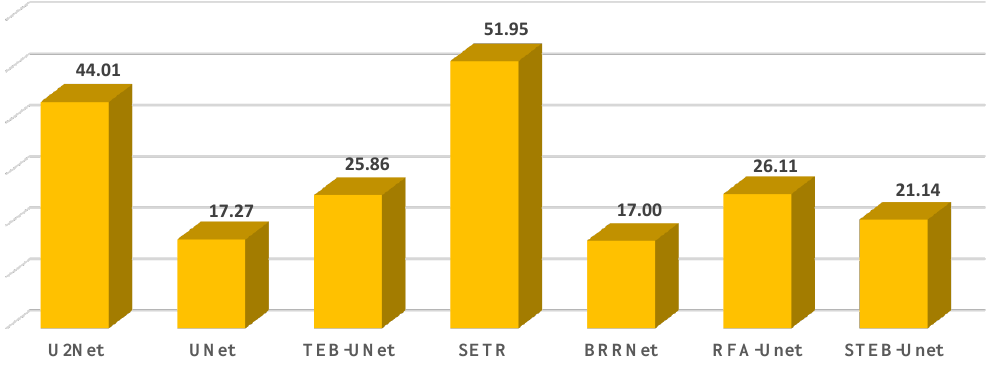
Figure 7. The number of parameters (Millions) of different